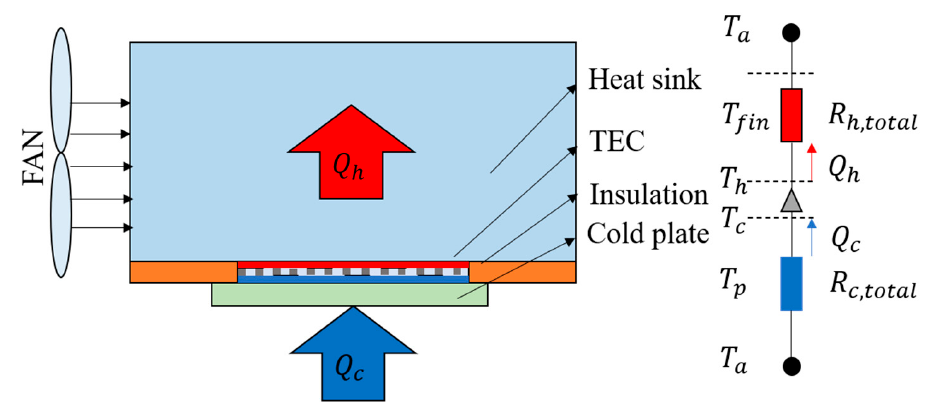
Figure 1. Schematic diagram of thermoelectric refrigeration model and thermal resistance network diagram.